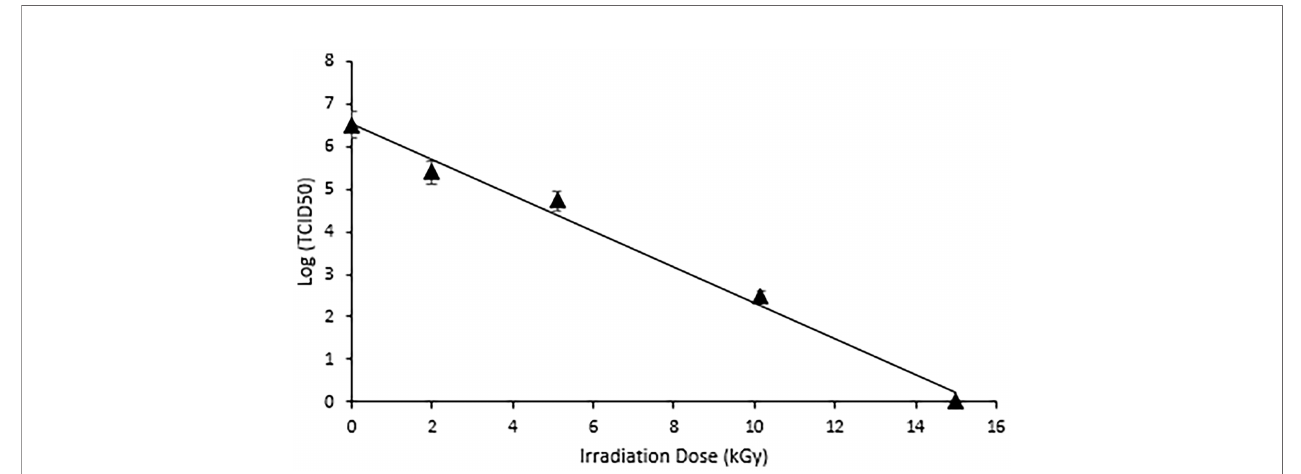
FIGURE 1 | Complete Inactivation of HRV was achieved at 15 kGy. Dose response curve illustrating the effects of electron beam irradiation on HRV stocks. The target doses were set at 0, 2, 5, 10, and 15 kGy and the measured doses were 1.99 kGy, 5.1 kGy, 10.15 kGy, and 15.0 kGy. A TCID50 assay was used to quantify the reduction in viral titer. The D 10 value, or dose required to achieve a 1-log reduction in viral titer was calculated as 2.38 (± 0.017) kGy. Complete inactivation was achieved at